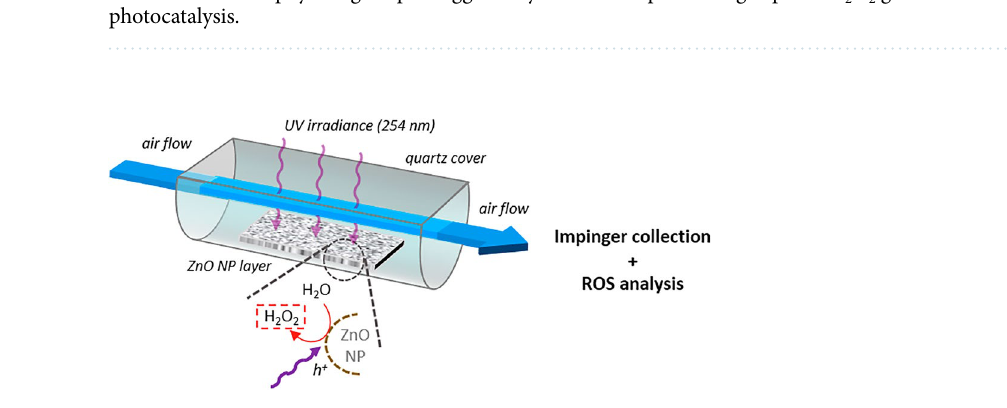
Figure 1. Schematics of the 2-steps MFF mechanism hypothesis that relies on specific conditions where chronic exposure to magnetite nanoparticles eventually stabilized with biological ligands in the airway undergoes Fenton reaction at physiological pH triggered by the acute exposure to gas-phase H 2 O 2 generated via ZnO-UV photocatalysis.